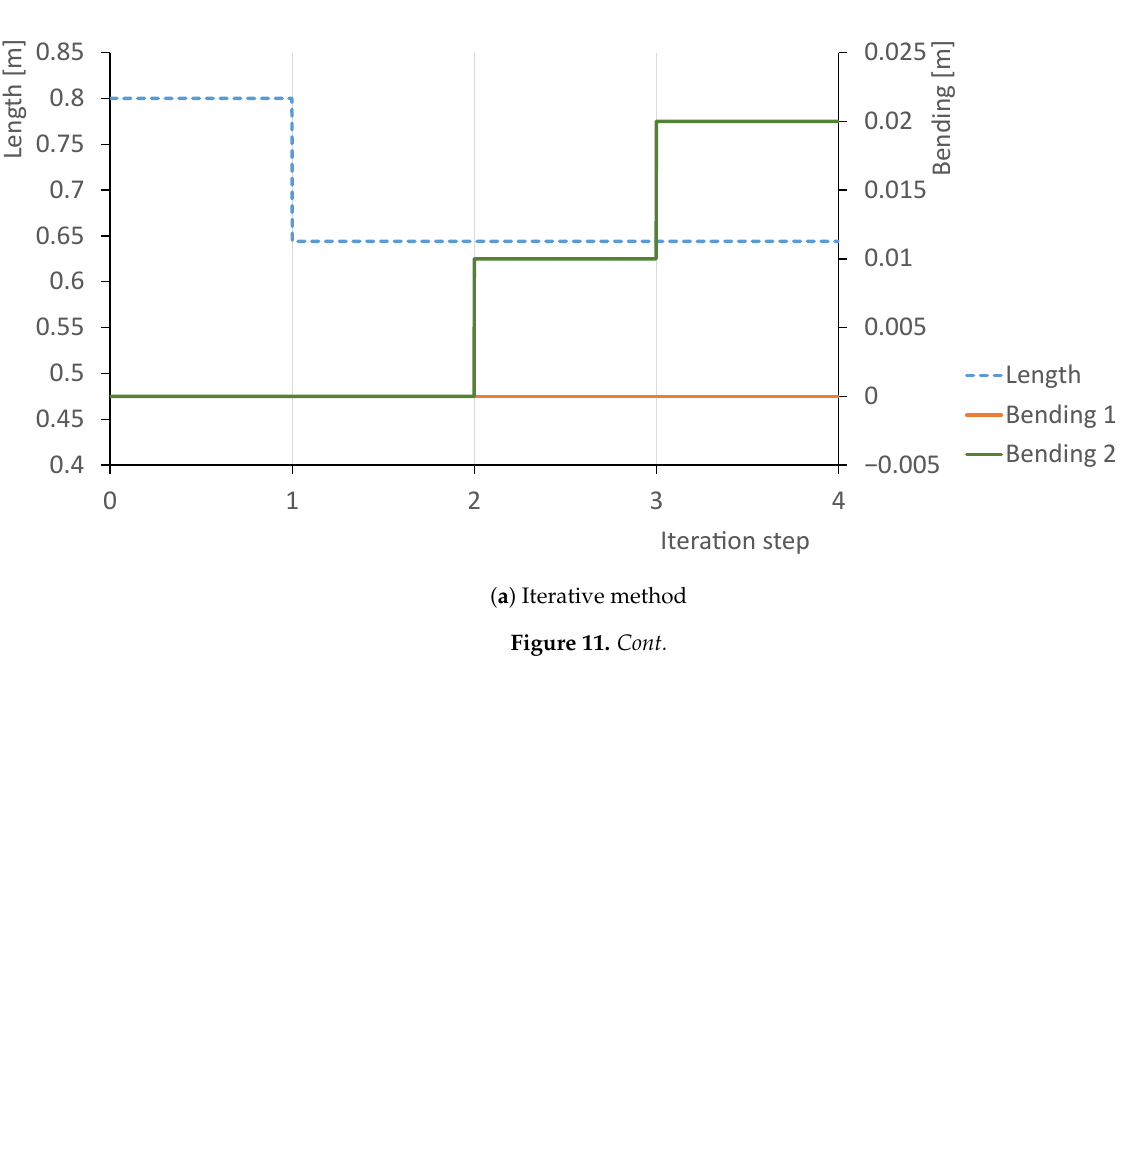
Figure 10. Results for the first testing workplace.